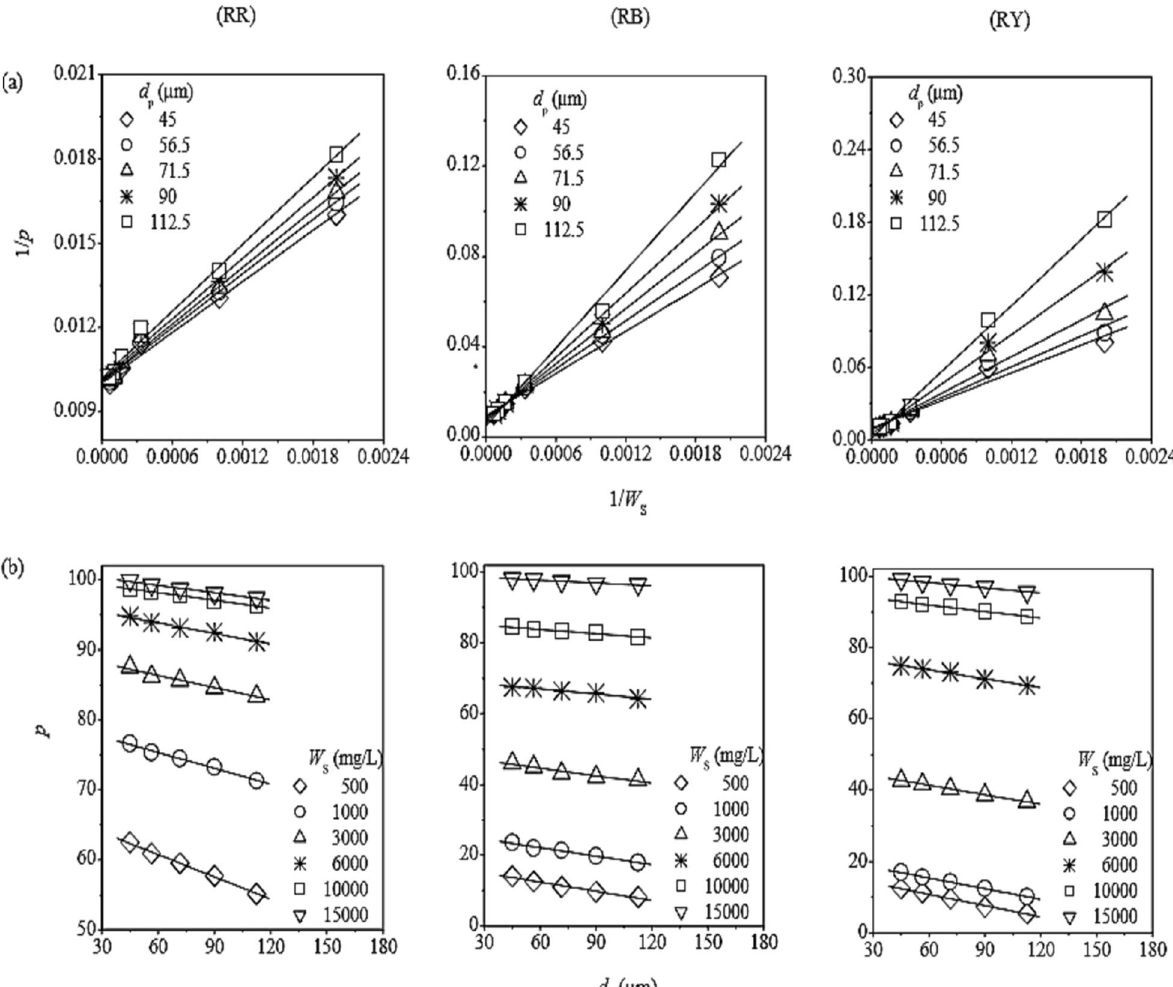
Fig. 9 Adsorption (%) of RB, RR and RY reactive dyes from aqueous solutions by CFA (Kara et al.